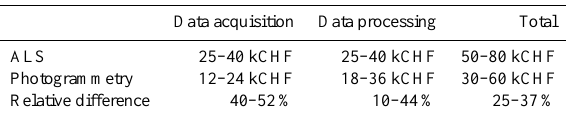
Table 5. Price ranges in thousands of Swiss Franks (kCHF) and relative differences derived from quotations of three independent data providers. We asked to cover the investigation area of this pa- per (145km 2 ) with airborne laser scanning (ALS) and digital pho- togrammetry with a spatial resolution of 2m and a vertical accuracy of approx.